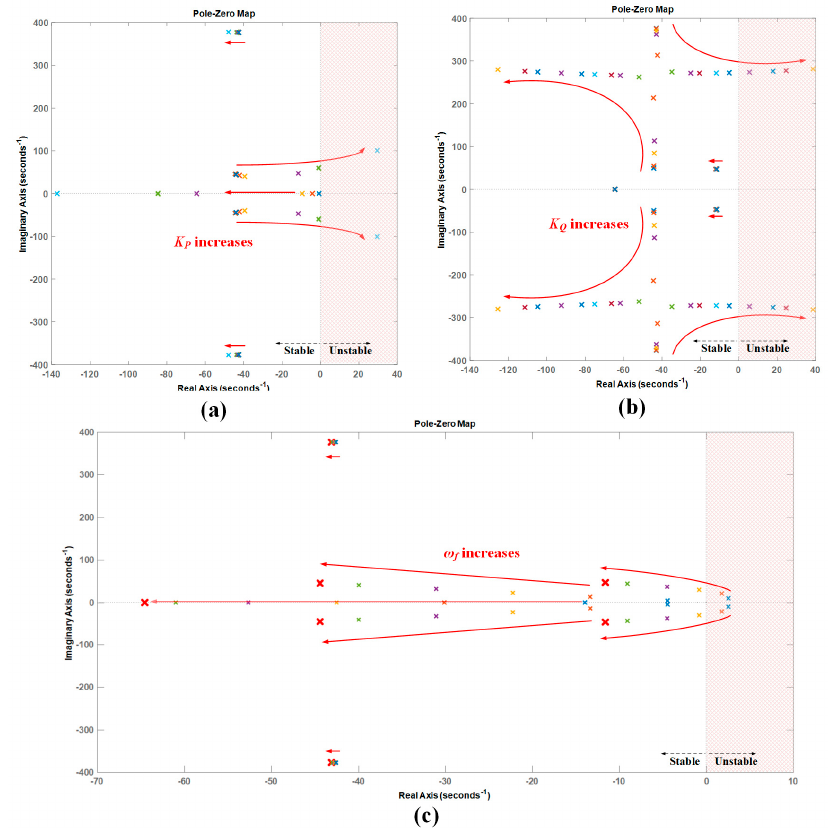
Figure 3. Stability determination of dynamic phasor model-based droop-controlled inverter with